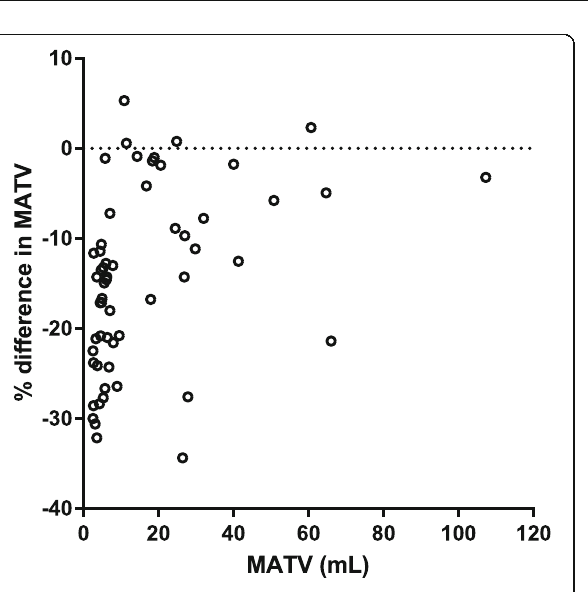
Fig. 3 Relative difference (%) in lesion MATV (mL) between uncorrected and PVC images (LR + HYPR) as function of MATV on uncorrected images. Y -axis was scaled to − 40%; for one lesion of 5.8 mL MATV was 69% smaller on PVC image